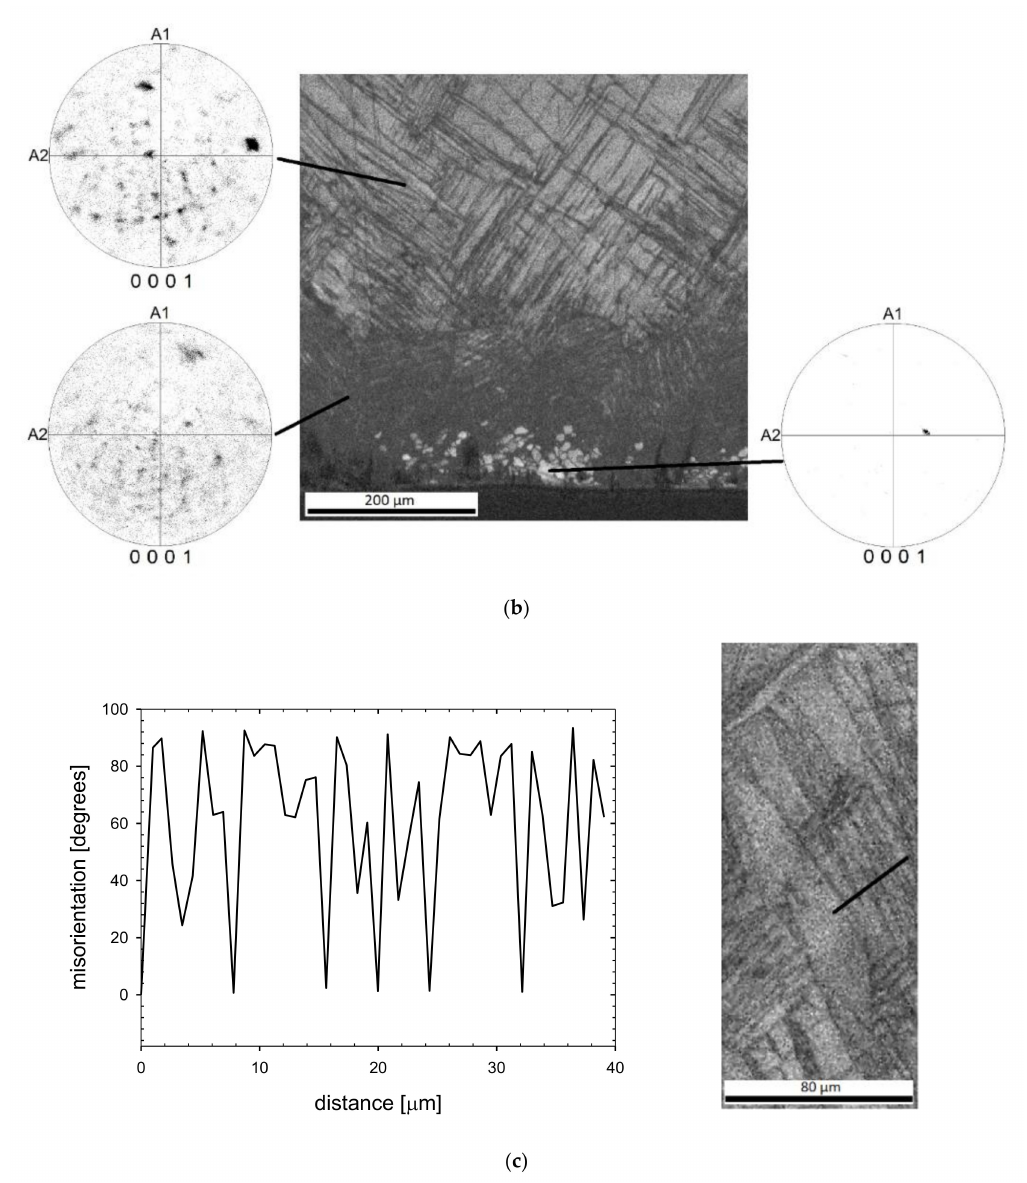
Figure 2. A typical microstructure on the cross-section of the sample SMATed for 120 s (SMATed surface can be seen in the bottom): ( a ) optical microscopy, polarized light, ( b ) the Image Quality Microstructure reconstructed from electron backscatter di ff raction (EBSD) measurements and corresponding local crystallographic orientations shown in 0001 pole figures, and ( c ) magnification of a selected subsurface area with corresponding misorientations along the marked black